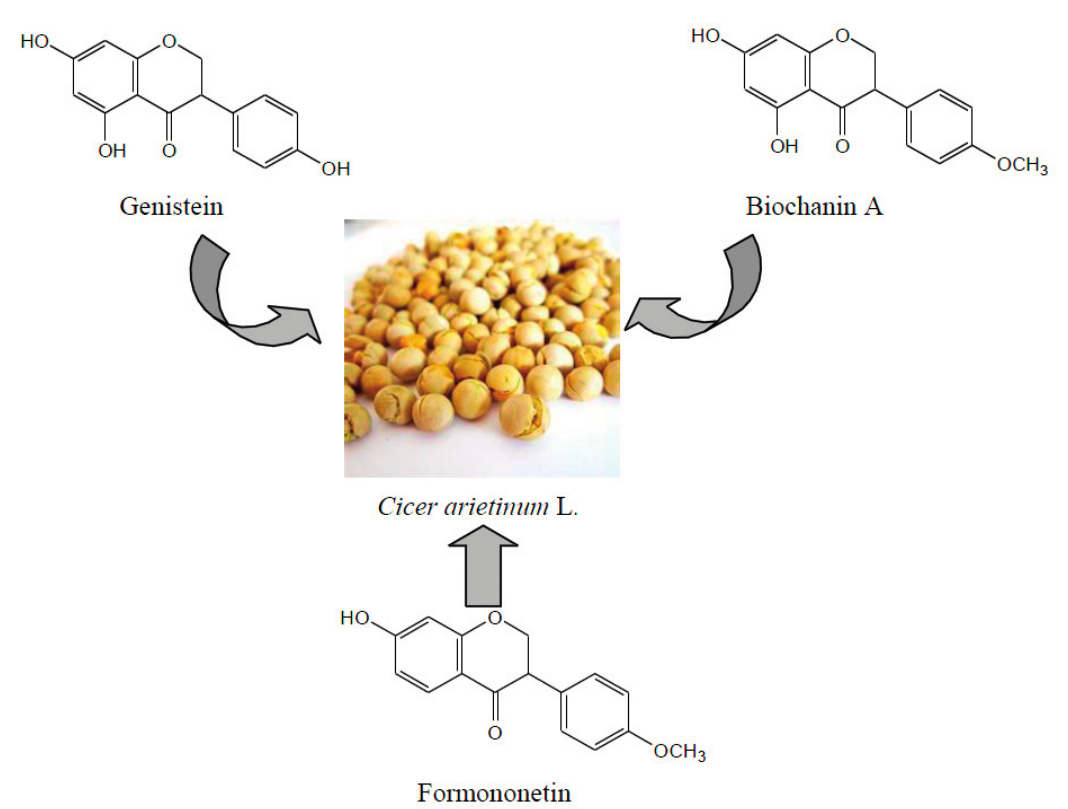
Figure 1. The structures of genistein, biochanin A, and